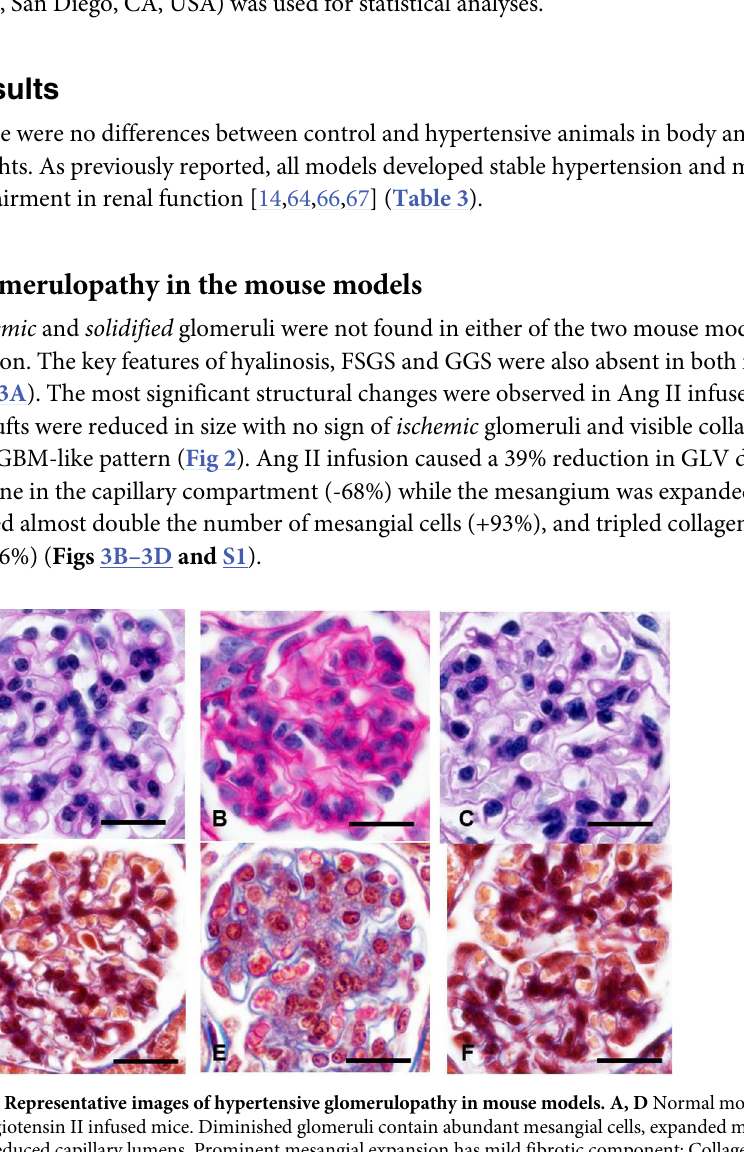
PLOS ONE | https://doi.org/10.1371/journal.pone.0264136 February 17,